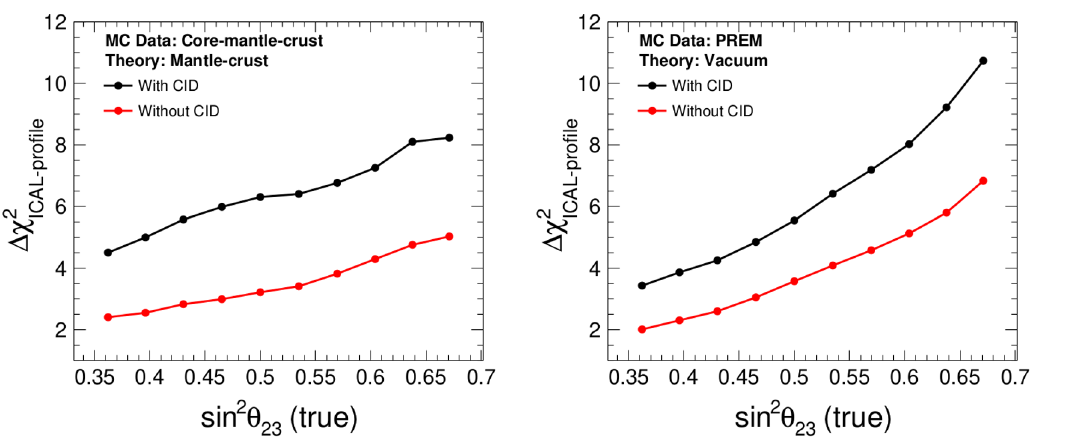
as a function of the choice of sin 2 θ in data. The median Figure 7 . The median ∆ χ 2 23 ICAL-profile ∆ χ 2 is the sensitivity with which we can validate Earth’s core by ruling out the mantle- ICAL-profile crust profile in theory w.r.t. the core-mantle-crust profile in data as shown in the left panel. The right panel shows the sensitivity at median ∆ χ 2 level to rule out vacuum scenario in theory ICAL-profile w.r.t. the PREM profile in data. In both the panels, the black (red) curve shows the sensitivity with (without) charged identification capability of ICAL. Note that we marginalize over oscillation parameters sin 2 θ , ∆ m 2 , and mass ordering, whereas the remaining oscillation parameters are 23 eff kept fixed at their benchmark values as mentioned in table 2. We assume mass ordering as NO in